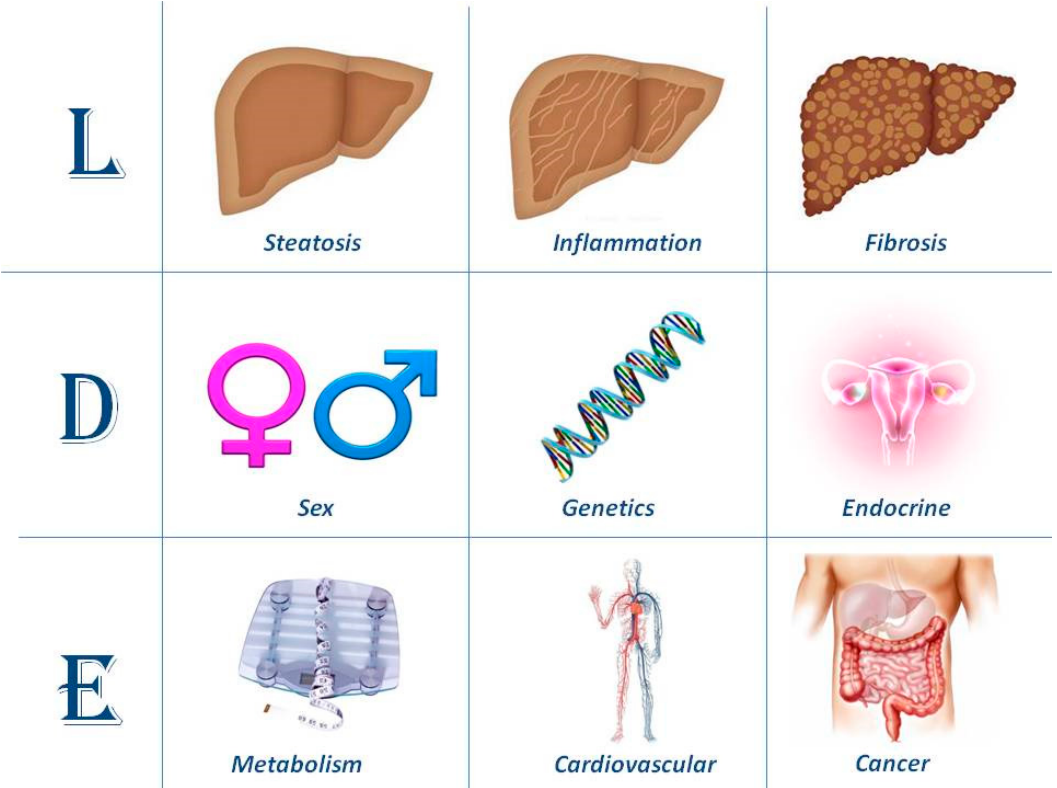
Figure 2. Articulating the taxonomy of nonalcoholic fatty liver disease (NAFLD)/ metabolic-associated fatty liver disease (MAFLD) with the LDE system. This schematic figure illustrates the proposed high standard of accuracy in defining NAFLD/MAFLD cases to be recruited for trials of innovative treatment, as well as for a better prediction of the natural course of disease in the individual patient. In its essence, the system requires clarification of nine criteria that should be recorded to better characterize cohorts of patients recruited in randomized controlled trials.